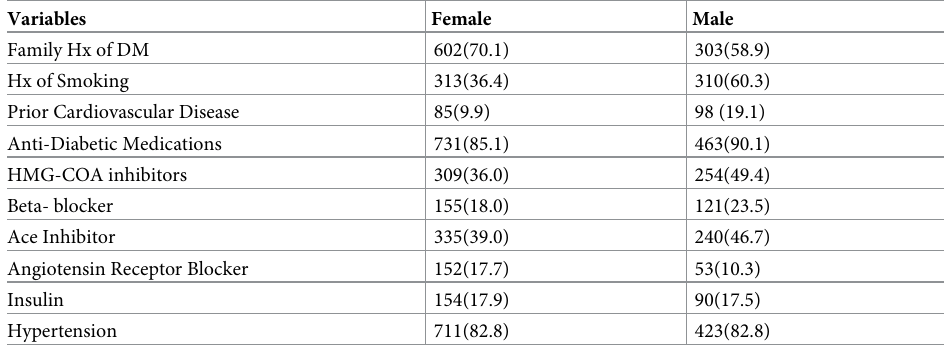
Table 3. Frequency distribution of the different nominal variables for females and